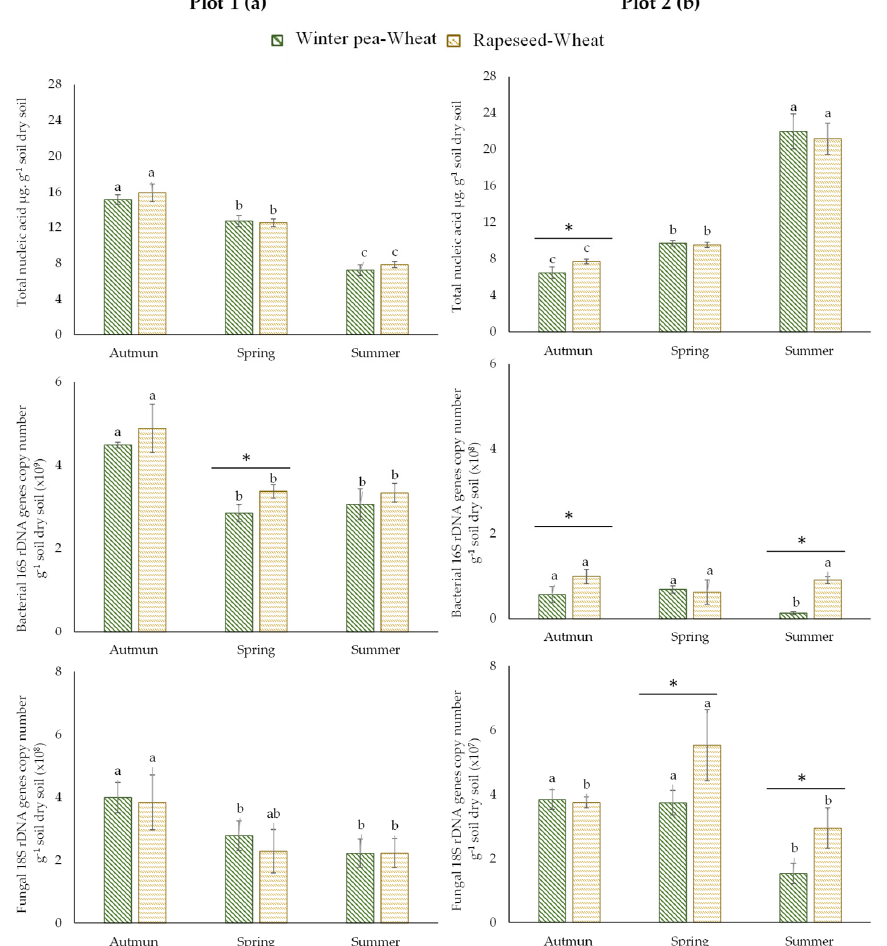
Figure 2. Total microbial communities, bacterial and fungal abundance in two crop succession (winter pea–wheat, rapeseed–wheat) at 3 sampling dates in the plot 1 ( a ) and plot 2 ( b ). Error bars on data points represent the standard errors of the mean of three replicates ( n = 3). Letters indicate statistical significance between the 3 sampling dates and asterisks indicate statistical significance between the two successions (pea–wheat vs. rapeseed–wheat) at p < 0.05 according to Tukey’s